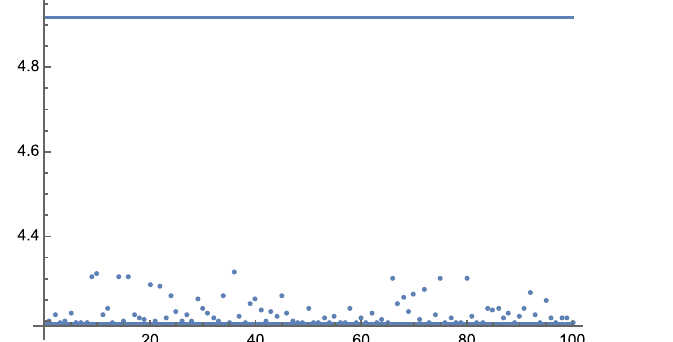
Fig. 16 The variances V [ F ] of Example 6 computed for 100 independent executions with the linear heuristic, where we set α 1 = 0 , using 100 samples for each of the other two techniques. The horizontal lines correspond to the optimal and the equal sampling budget variances, respectively